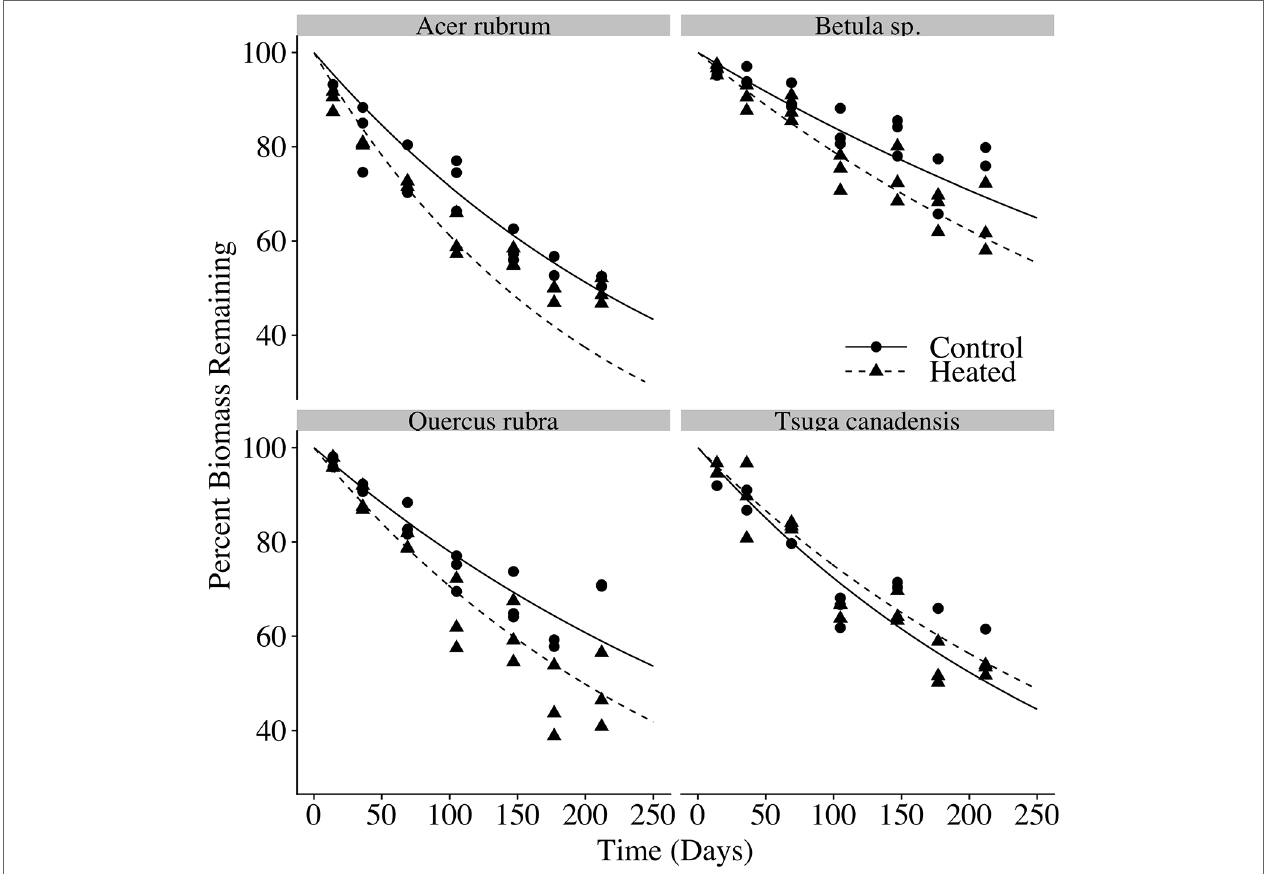
FIGURE 4 | Litterbag mass loss over time. The percent of initial biomass remaining at time of harvest is plotted for each litter bag. Exponential decay curves of the form y = 100e −kt are plotted for the control and heated litterbags for each of the four species, where k is the mean decay constant for each species × treatment, and t is the number of days deployed.